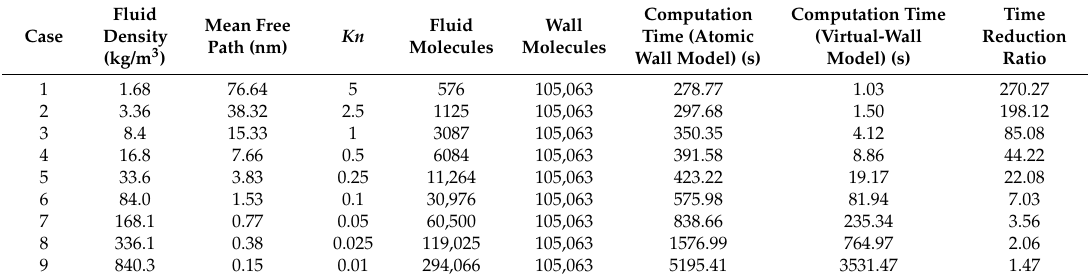
Table 1. Comparison of computational times between the atomic and virtual-wall models.